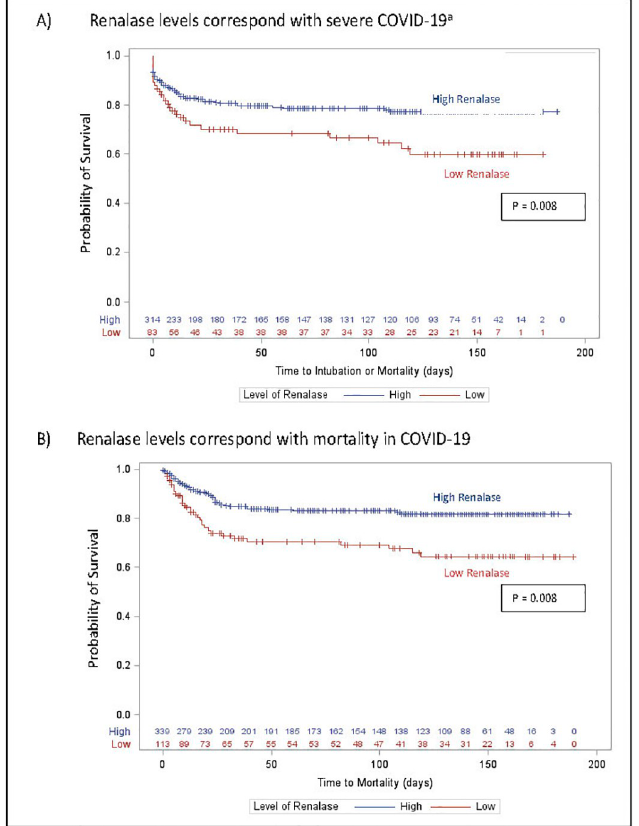
Fig 2. Time adjusted survival curves for high vs. low renalase among patients with COVID-19 disease (using first quartile as cutoff). Kaplan-Meir curves created and compared using log-rank test. (A) For composite outcome a : High renalase; Low renalase and (B) For Mortality: High renalase; Low renalase. a For composite outcomes, patients with renalase samples drawn after intubution were excluded from survival analysis (n = 55).